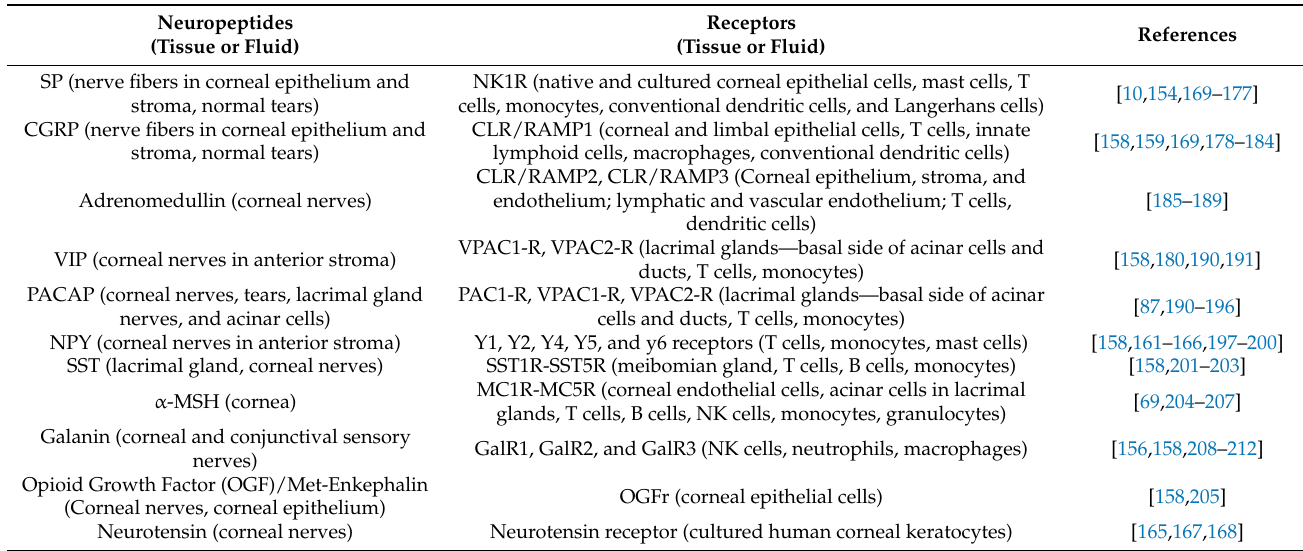
Table 2. Expression of neuropeptides and their receptors on the ocular surface.